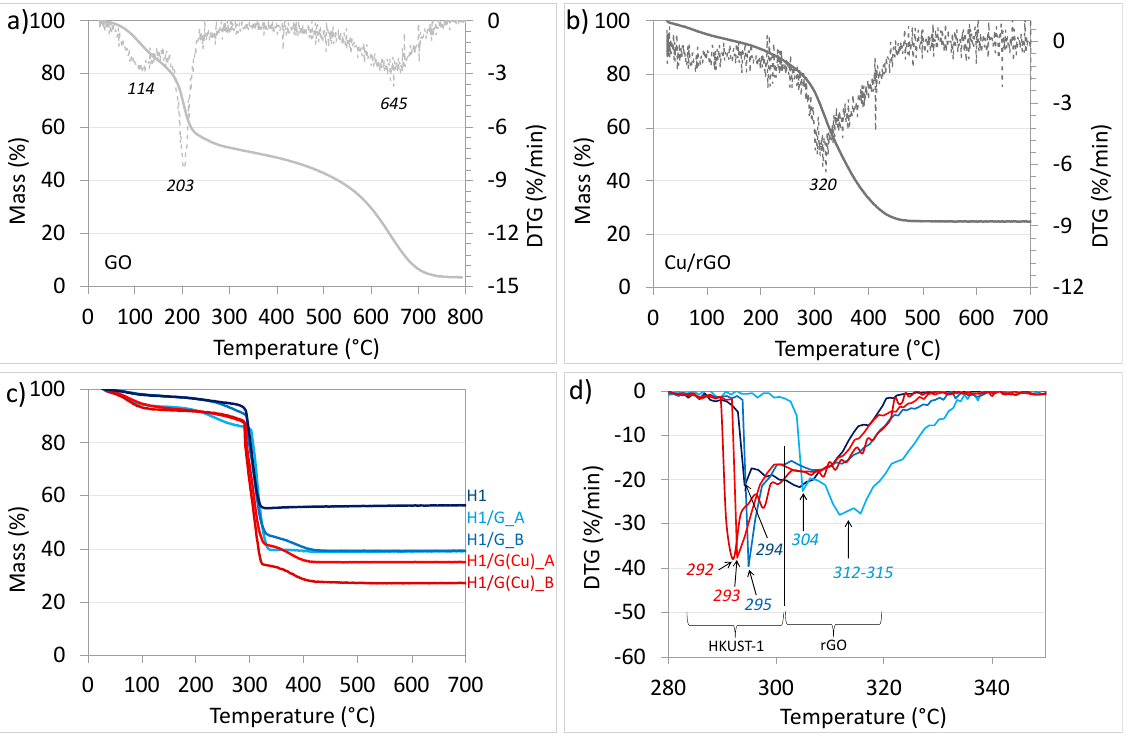
Figure 7. TG (solid line) and DTG (dotted line) for GO ( a ) and Cu/rGO ( b ). The collective TG ( c ) and DTG ( d ) for H1, H1/G_A, H1/G_B, H1/G(Cu)_A, and H1/G(Cu)_B. Table 3. Qualitative and quantitative composition of composites determined from TGA. Wt.% of Component in the Sample Sample BTC 3 − Linker Graphene